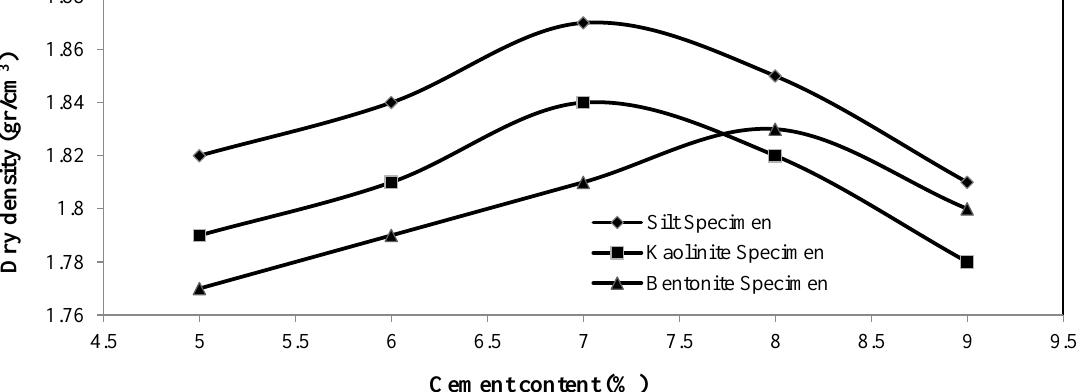
Fig. 4. Effect of cement content on the maximum dry density of the mixtures with different types of